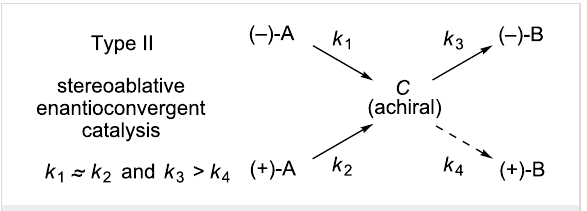
Stoltz and co-workers have reported an approach for the prepa- ration of enantioenriched oxindole derivatives from racemic oxindole halides using a stereoablative approach (Scheme 3) [22,23]. Deprotonation and elimination of the halide in oxin- dole (±)- 8 leads to achiral azaxylylene intermediate 11 , which is trapped with malonate nucleophiles to form all-carbon quater- nary centers. The overall transformation is unusual since oxin- doles are typically nucleophilic, but in this case the stereoabla- tive step in the mechanism leads to an electrophilic